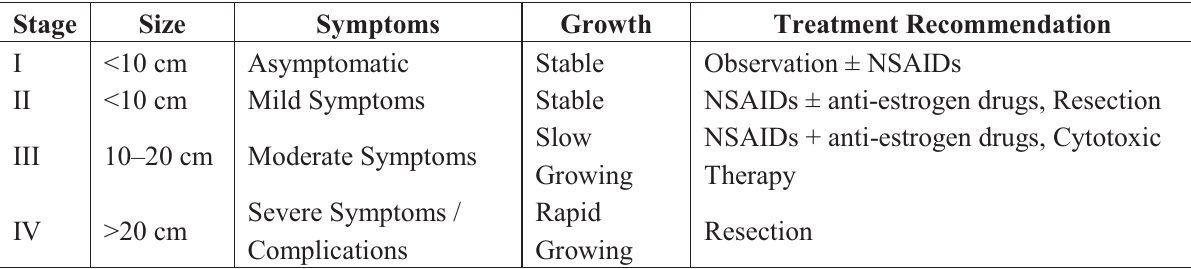
Table 1. Clinical staging of intra-abdominal